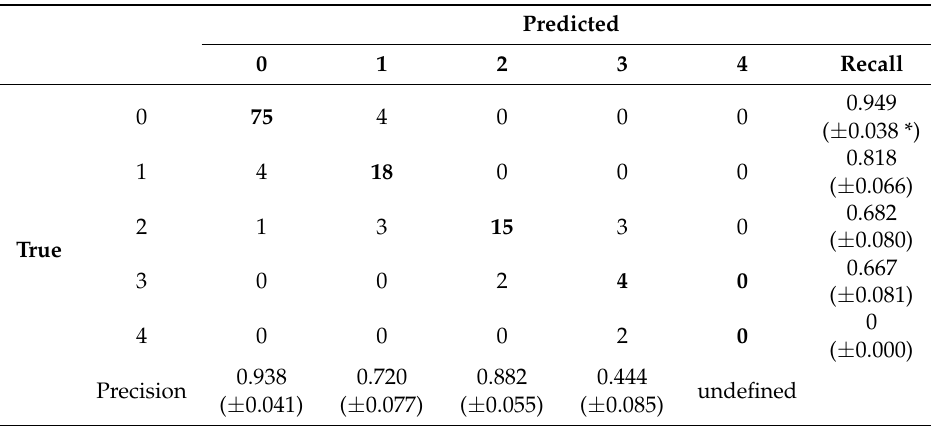
Table 5. Confusion matrix of the UPDRS predicted by the proposed